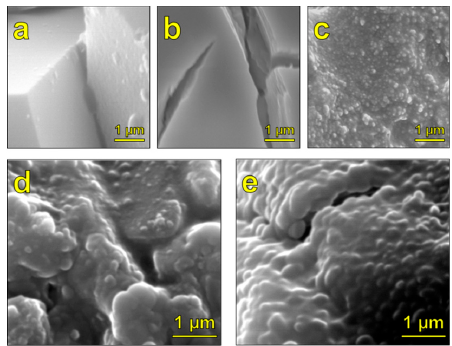
Figure 3. Scanning electron microscopy micrographs of the biocalcareous stone under study: ( a ) untreated; ( b ) treated with TV100; ( c ) treated with BS290; ( d ) treated with UCA-T; and ( e ) treated with UCA-TS.